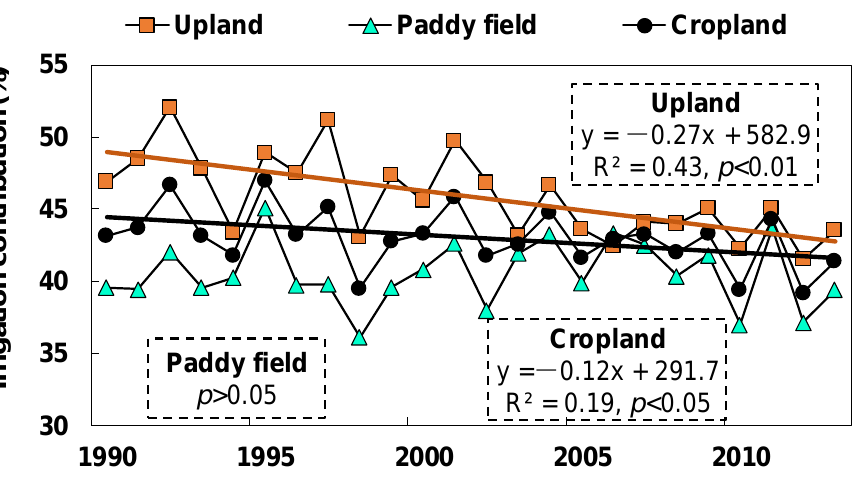
Figure 7. Temporal trend of the irrigation contribution to cropland runoff during 1990–2013 in China.